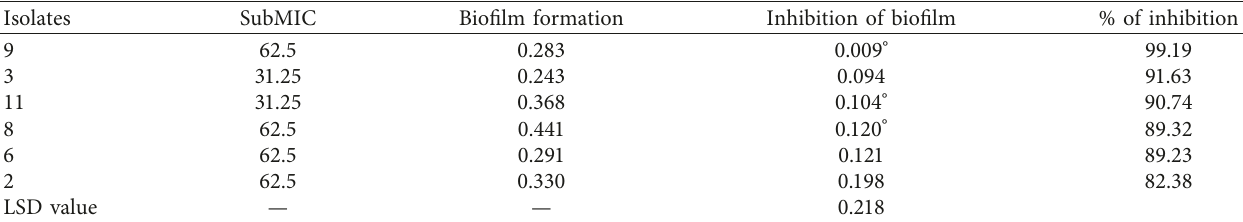
Table 10: The biofilm formation and biofilm inhibition activity of the hydantoin compound C5 in S. aureus isolates according to subMIC. Isolates